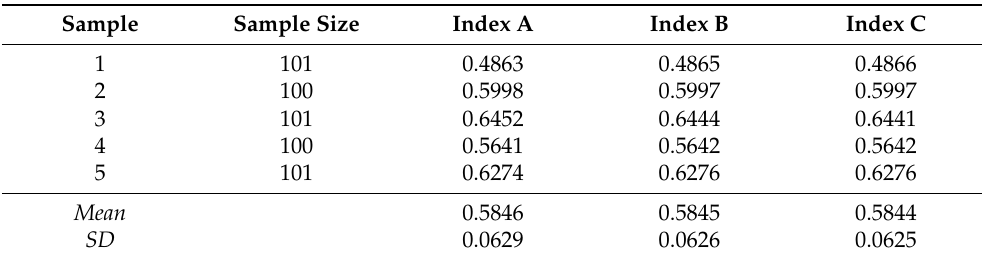
Table 1. Coefficients from the statistical learning methods using Ridge regression (Model 1), cross- validation (Model 2), and linear regression (Model 3), using percentage of green foods and percent- age of red foods as predictors and HEI score as the outcome ( n = 503). Table 2. Pearson’s correlation coefficients between HEI and tier-ranked index scores obtained using 5-fold cross-validation